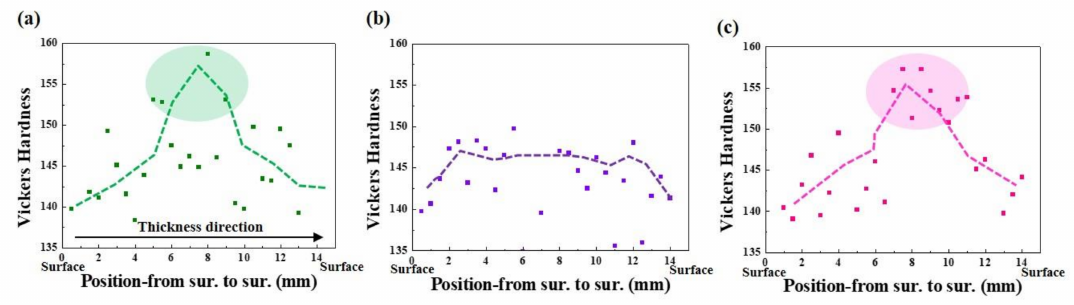
Figure 4. Through-thickness hardness distribution: ( a ) Steel A, ( b ) Steel B, and ( c ) Steel